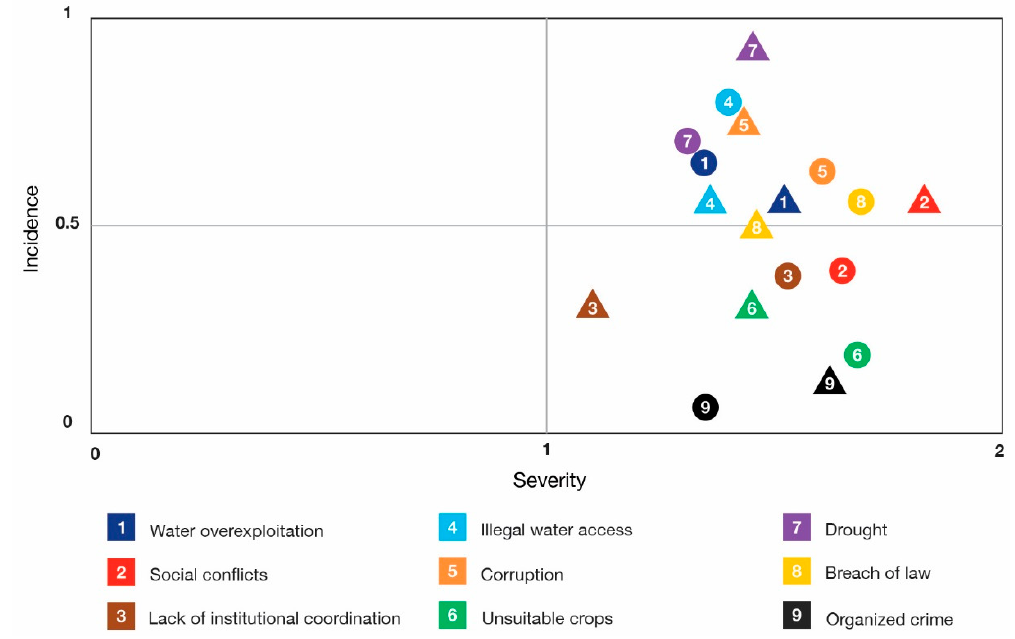
Figure 5. Scatter plot that displays the problems identified by Mexican farmers (circles) and Mennonites (triangles) according to their severity and incidence. The severity index ranges from 0 (least severe) to 2 (most severe); the incidence index ranges from 0 (not mentioned) to 1 (most